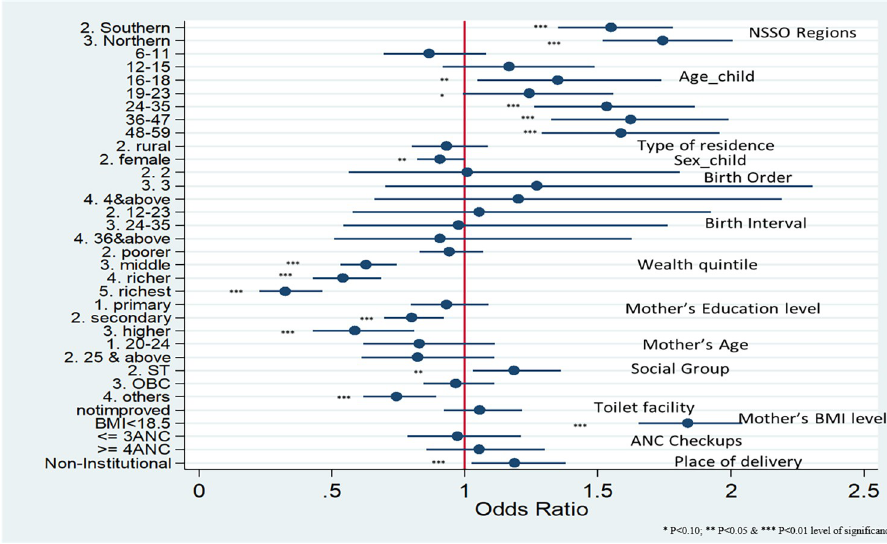
Fig 6. Model 1: Impact of NSSO regions, along with socio-economic background characteristics, on children underweight, for Odisha, assessed by logistic regression using NFHS-4 (2015–16).